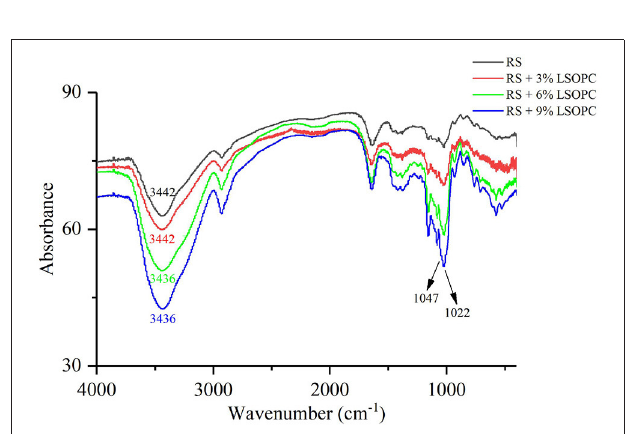
FIGURE 2 | Infrared spectroscopy spectra of RS with or without LSOPC.